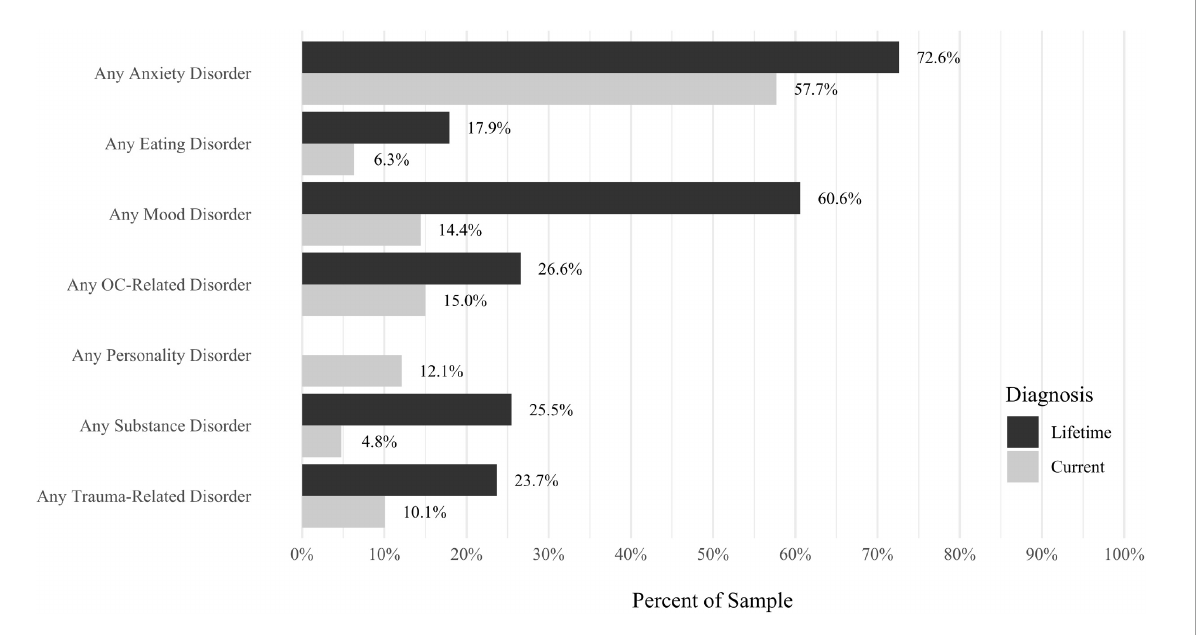
FIGURE8 Rates of psychiatric disorders: overall disorders. N = 207. All psychiatric diagnoses were determined with the Structured Clinical Interview for DSM-5 (SCID-5; First et al., 2015a). “Current” indicates a current diagnosis and “Lifetime” indicates a diagnosis during a participant’s lifetime. AMC, due to another medical condition. Disorders were not listed if they had a prevalence rate of 0% for both the Lifetime and Current diagnoses. If a disorder is not present in the Current or Lifetime categories, the disorder was not assessed as part of the structured interview.